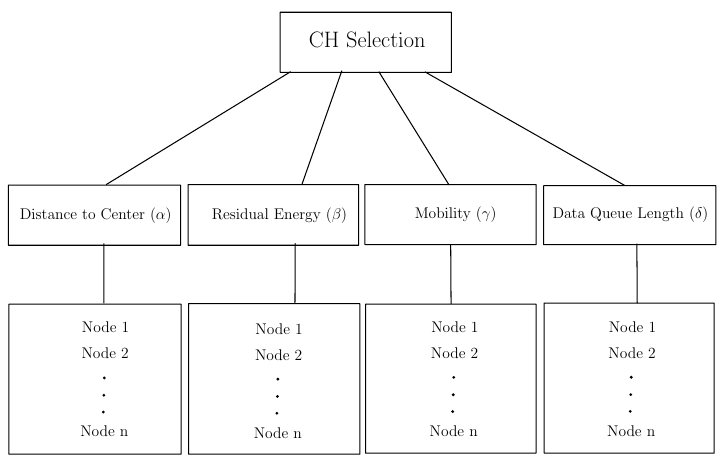
Figure 3. The structure of AHP for cluster head